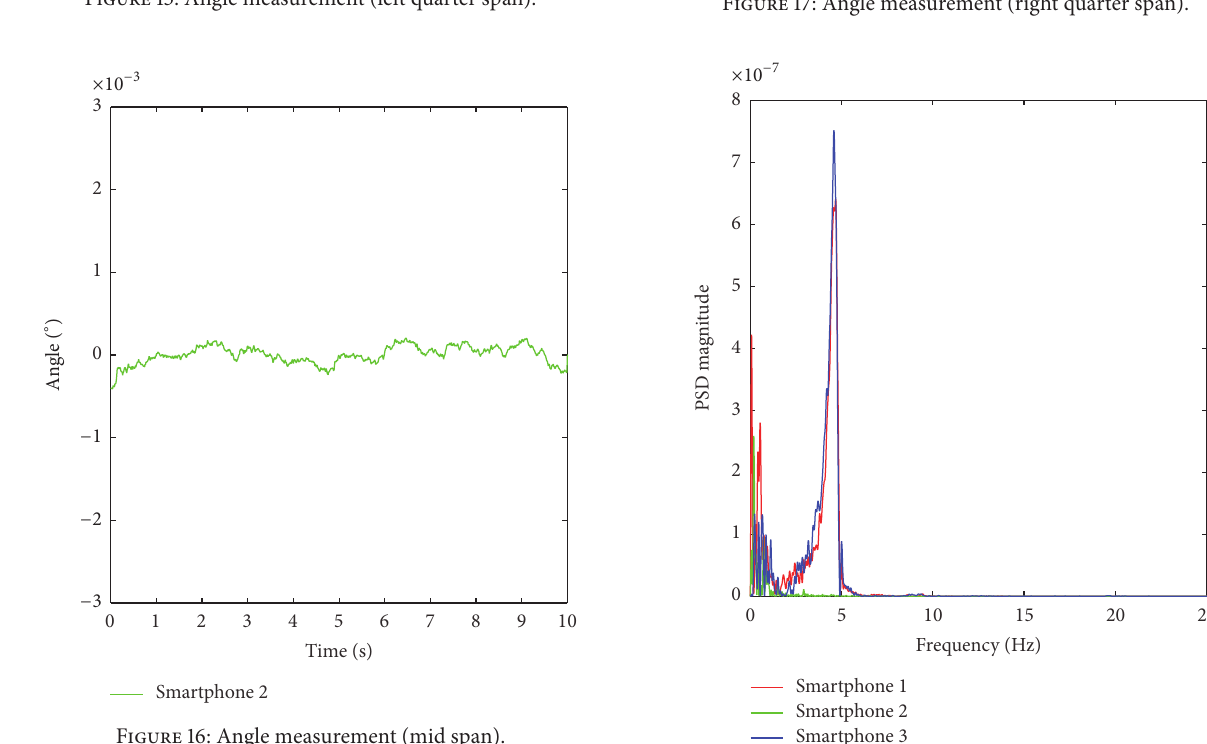
Figure 15: Angle measurement (left quarter span).